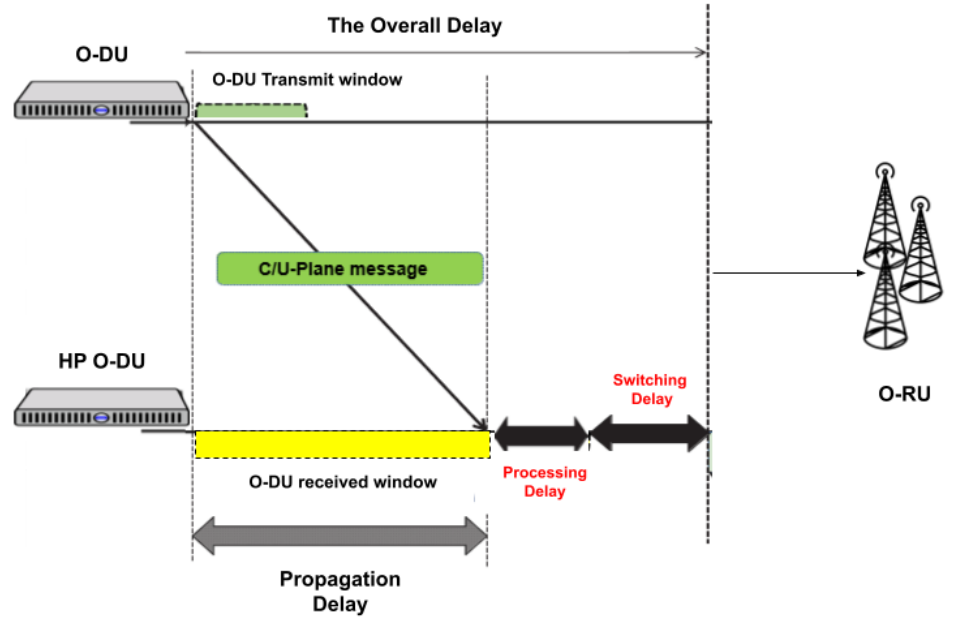
Figure 2. The overall delay in the